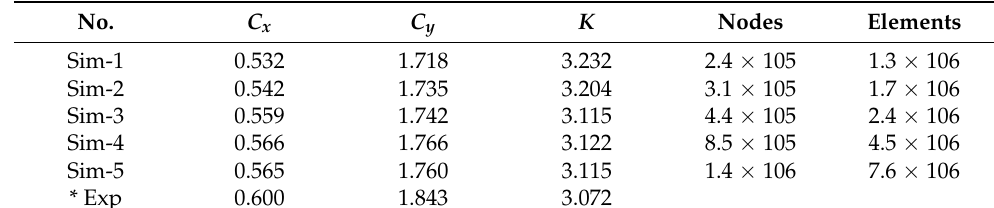
Table 5. Sensitivity analysis of the mesh resolution.